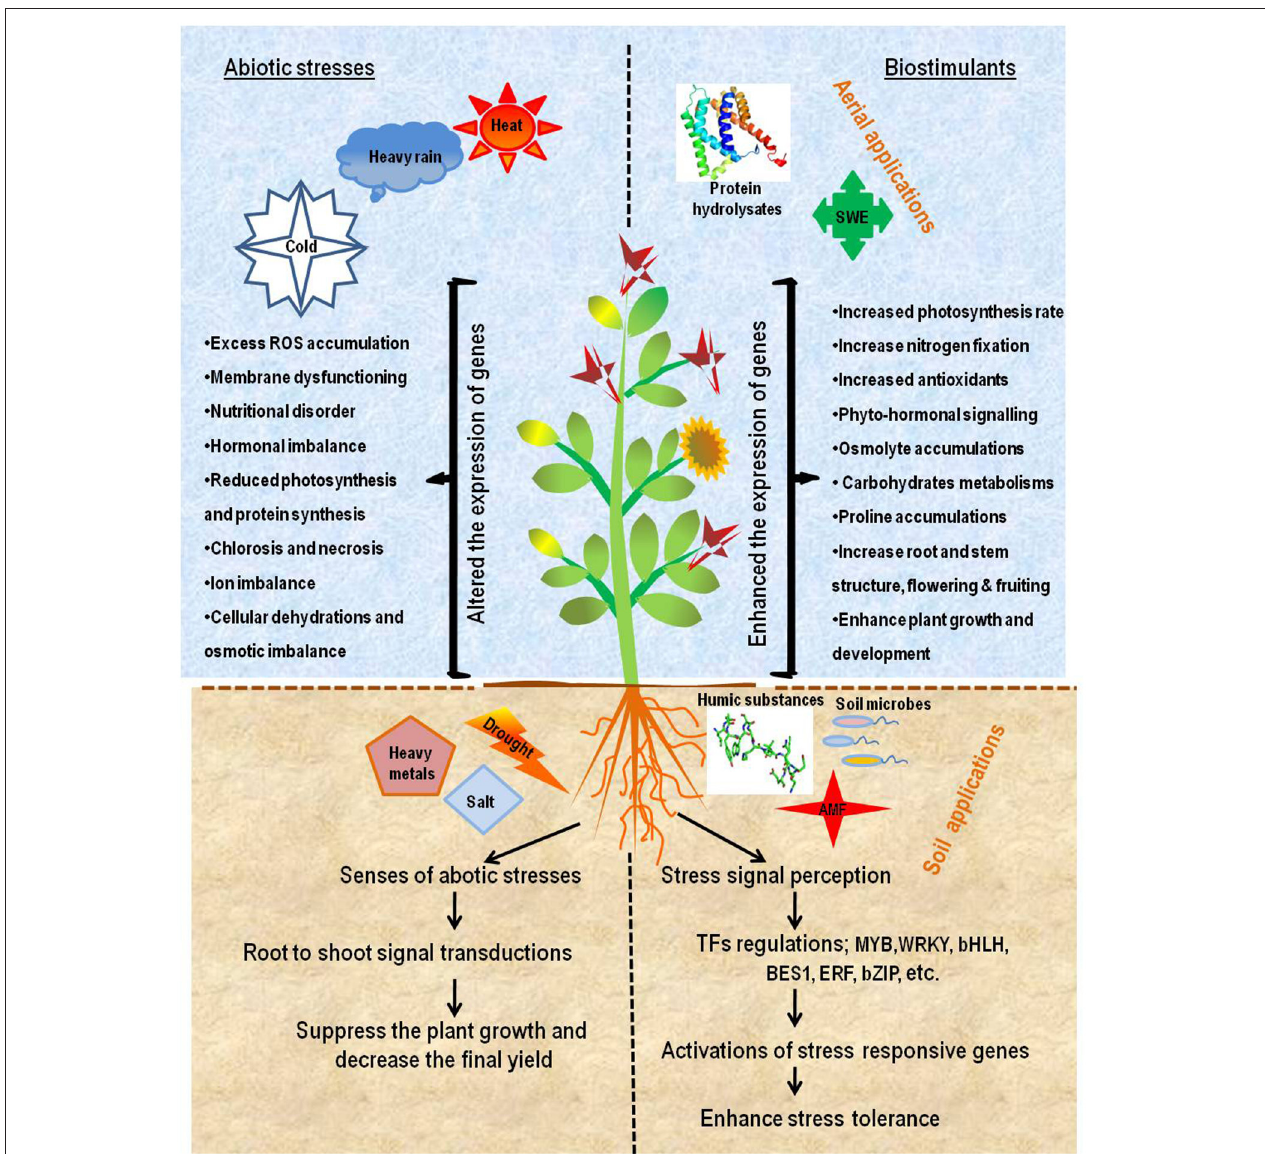
FIGURE 2 | Schematic representation of effects caused by abiotic stresses and biostimulants-mediated abiotic stresses tolerance in plants. The right side of the diagram represents plant damage due to a variety of abiotic stresses including cold, heat, heavy rain, salinity, etc. which eventually leads to yield losses. The left side of diagram represents foliar and soil application of biostimulants including, seaweed extracts (SWE), protein hydrolysates and humic substances, soil microbes, arbuscular mycorrhizal fungi (AMF), respectively, which drives many mechanisms for plant growth and development, regulates multiple transcription factors (TFs) and activates stress responsive genes, leading to enhanced stress